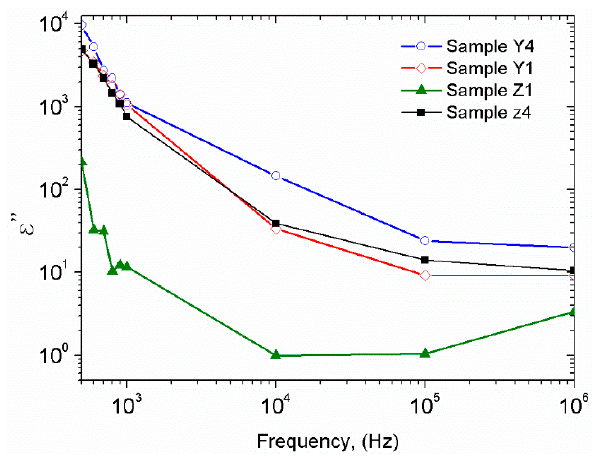
Figure 13. Variation of dielectric constant with frequency for the membranes of PVA with different content of ZnO Nps. The inset is a picture of one of the fabricated capacitors over glass substrates.